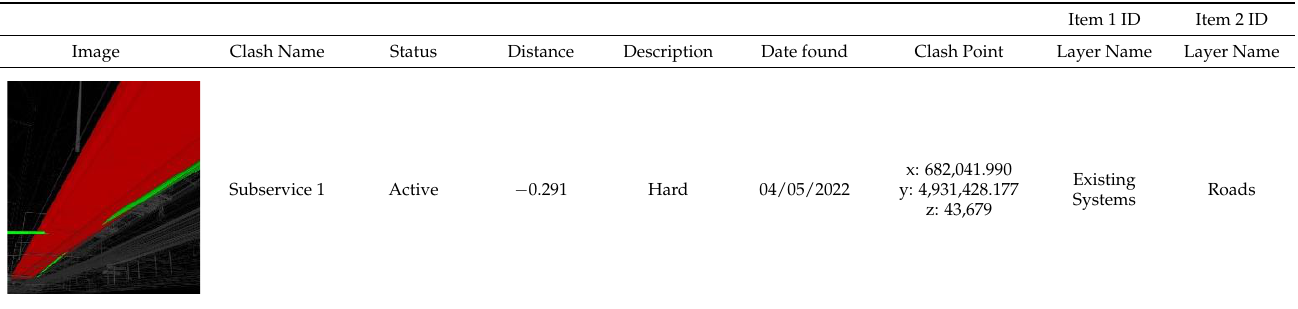
Table 4. Example of Clash Detection report in HTML format.